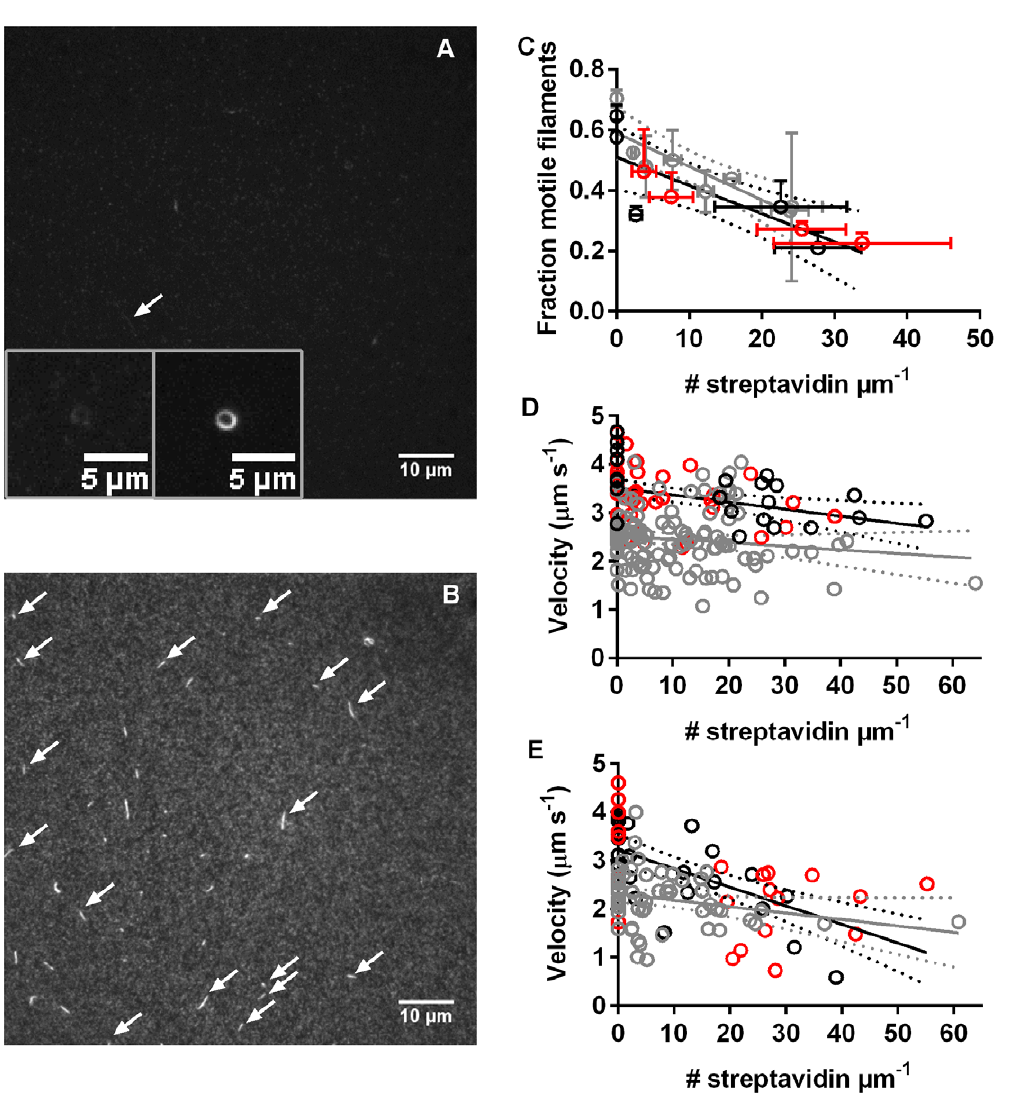
Figure 1. Effect of different degrees of streptavidin labelling on HMM induced actin filament motility. A. Biotinylated and APh labelled F-actin (5 nM), immobilized to HMM on a surface, then incubated with 1 nM TRITC-streptavidin for 1 min followed by rinsing and incubation by AMc130 assay solution. Observation using TRITC filter set. Arrow indicates motile TRITC-streptavidin labelled filament. Other filament-like objects represent cross-linked and non-motile filaments. Inset : nanospool of actin filament formed by intra-filament biotin-streptavidin cross-linking. Left image, TRITC-filter set to observe TRITC-streptavidin. Right image, FITC-filter set to observe Alexa-488-labelling of the same filament. B. Same conditions as in A except for incubation with 20 nM TRITC-streptavidin and 40 m M biotin in solution. Arrows indicate motile filaments. Note, brighter background than in A, presumably due to non-specific binding of TRITC-streptavidin. C. Fraction of motile filaments vs. average number of streptavidin molecules per m m filament length. Vertical error bars: SEM. Horizontal error bars: standard deviation. D. Velocity for filaments with different number of streptavidin molecules measured during the periods of smoothest sliding (CV , 0.5). E. Average velocity during 6–16 s plotted against number of streptavidin molecules per filament length. Black and grey symbols: two different experimental dates with different HMM, actin and streptavidin batches. Red symbols: covalently biotinylated F-actin with addition of 0–20 nM TRITC-streptavidin followed by 20 nM to 40 m M biotin, prior to motility assay. Same experimental date as black. Straight full lines obtained by linear regression as well as dashed lines representing 95% confidence intervals. An additional observation of interest was that one filament with two quantum dots executed nearly continuous counter- clockwise rotation for 164 s, apparently with one of the actin- attached quantum dots as an axis. Altogether, 30 full rotations in the same direction were observed. Similar behaviour is observed for one filament in Movie S4 (in the lower right, second half of the movie).